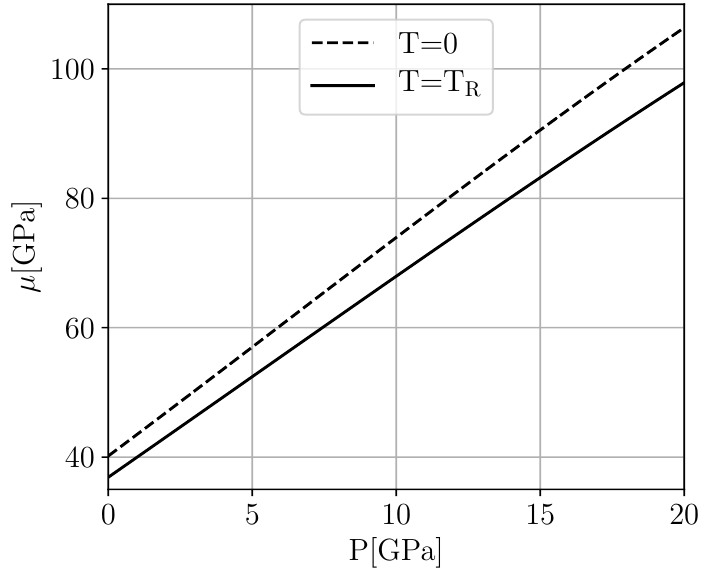
Figure 8. Pressure-dependent longitudinal shear modulus µ ( P ) at room temperature T = T R as determined by extrapolating the corresponding DFT result from T = 0 to T = T R based on Formula